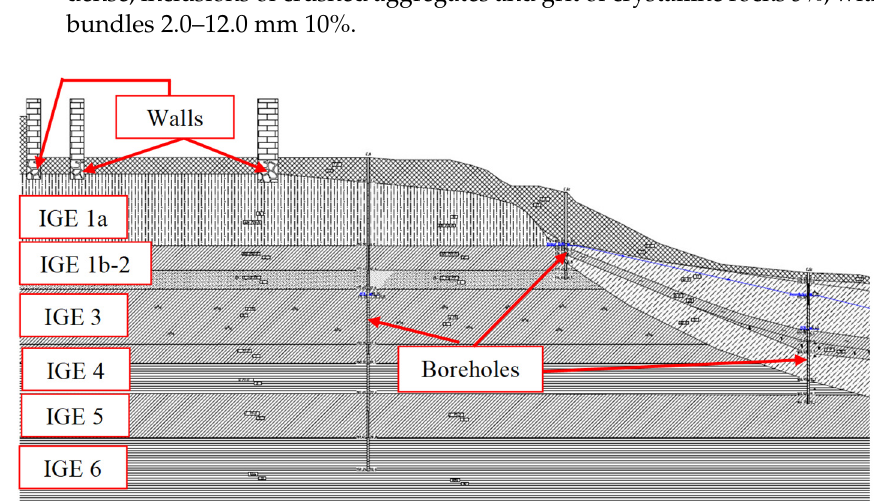
Figure 4. The engineering–geological structure of landslide hazard slope.